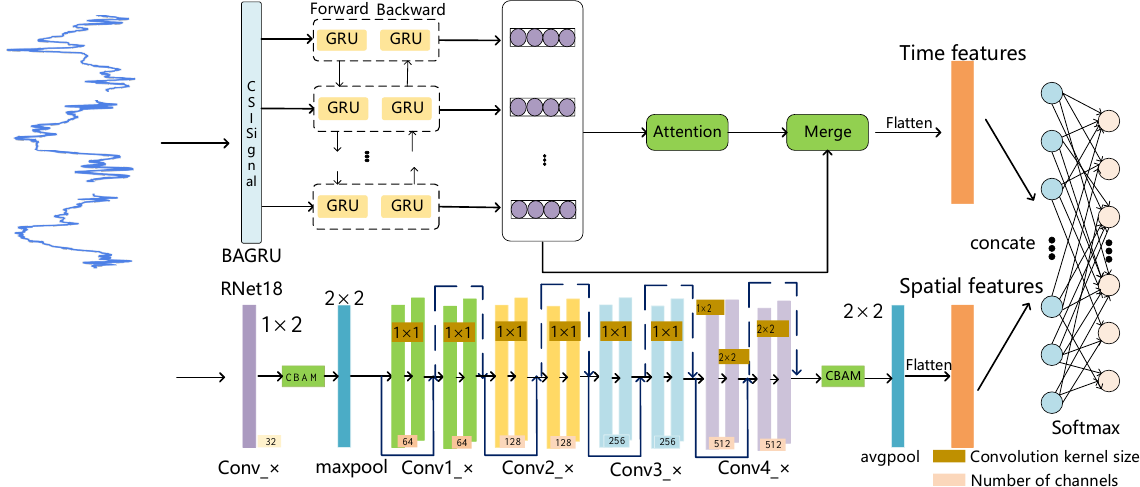
Figure 7. Flow chart of the RAGRU algorithm.